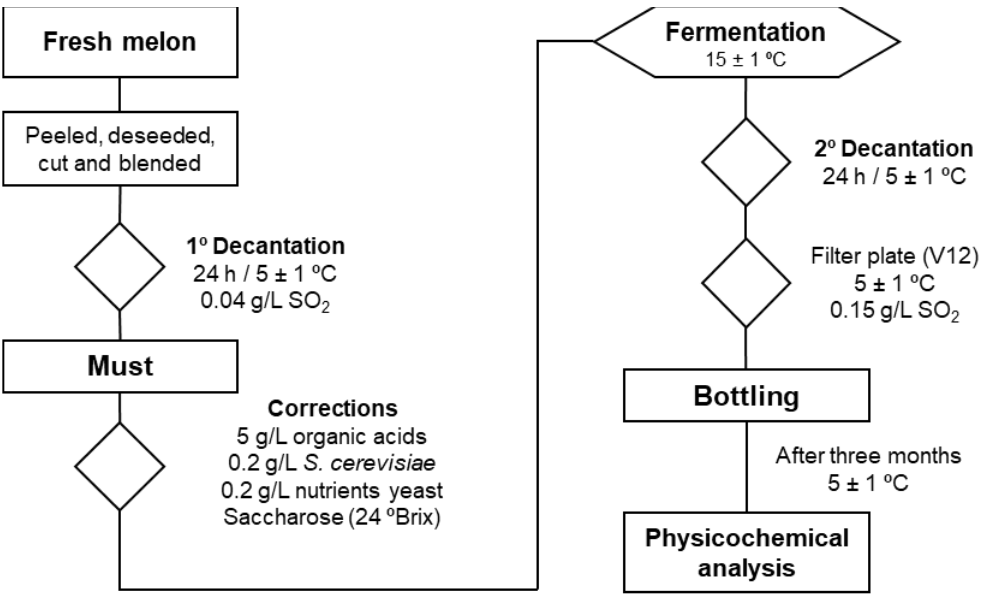
Figure 1. Scheme of the production of melon